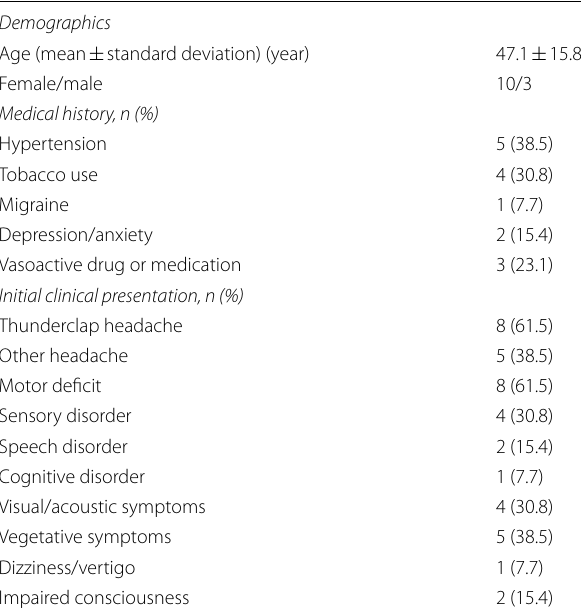
Table 3 Clinical characteristics